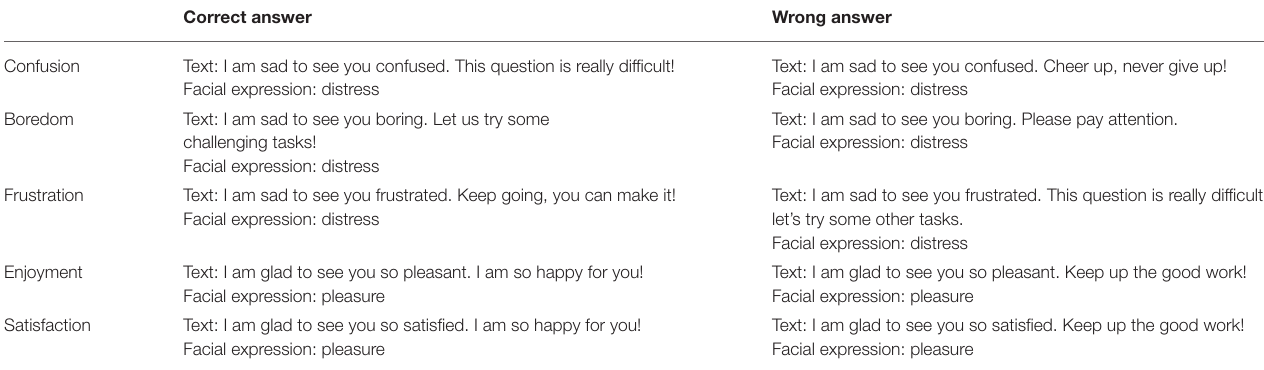
TABLE 2 | Rules of emotional feedback. Correct answer Wrong